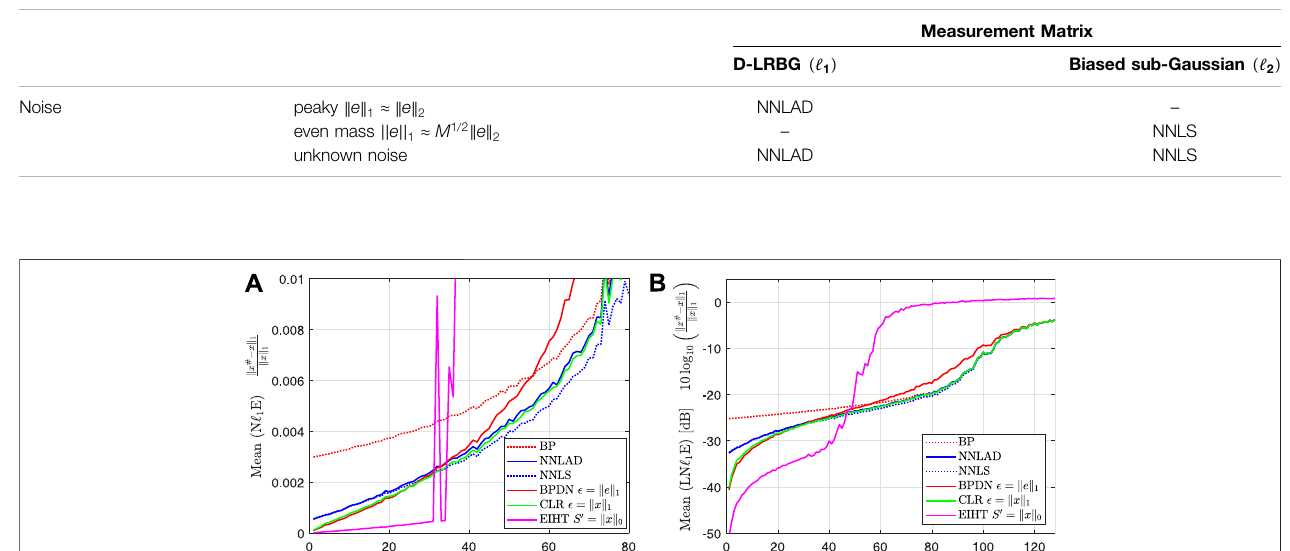
TABLE 1 | Table of advantages of NNLAD and NNLS over each other.